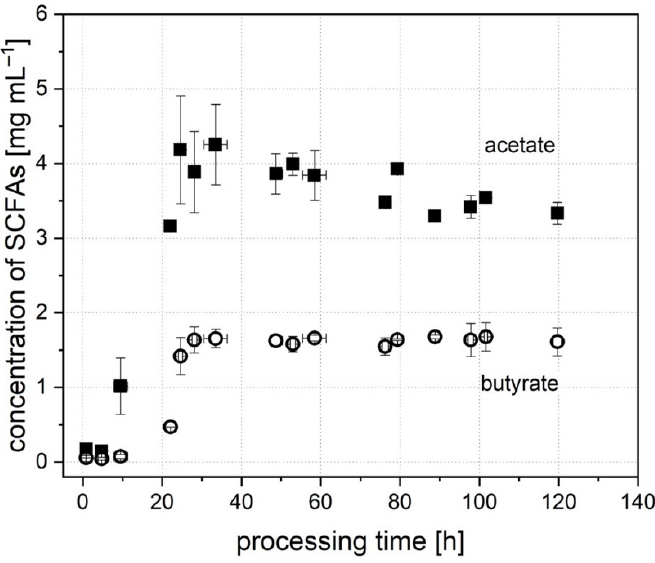
Figure 3. Concentration of the SCFAs, acetate and butyrate, throughout the processing time during the cultivation of donor A.